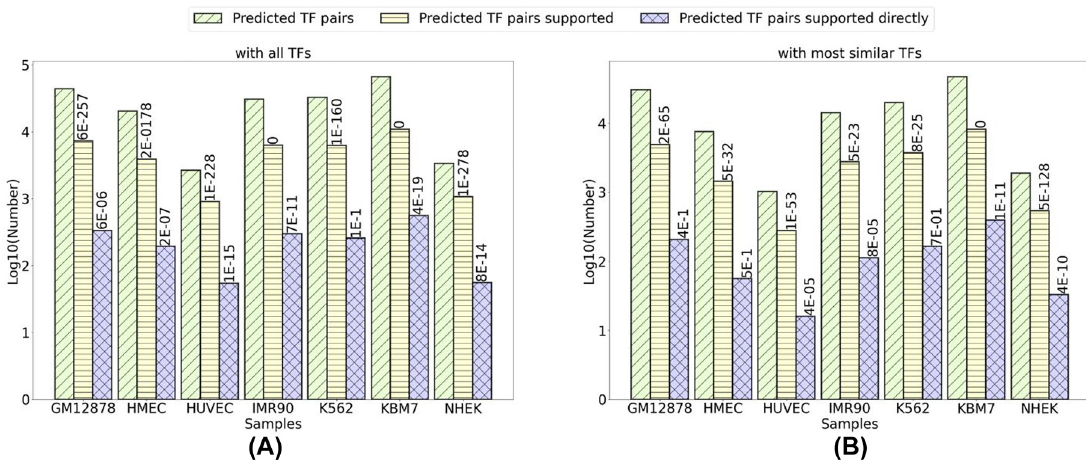
Figure 2: The predicted motif pairs are enriched with known interacting TF